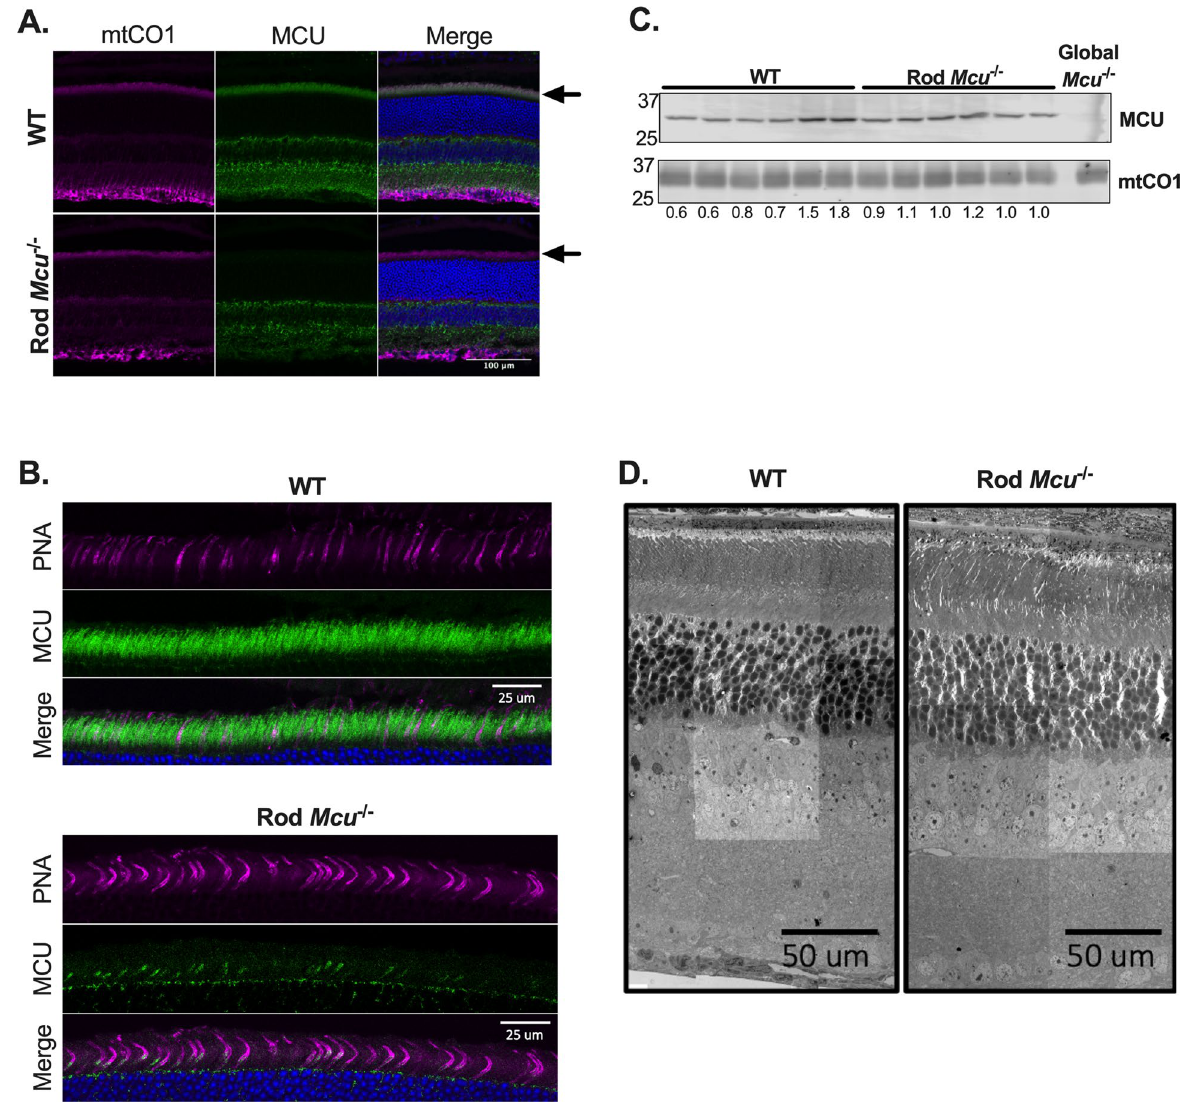
Figure 4. Rods express low levels of MCU. ( A ) Immunohistochemistry showing MCU expression in WT and Rod Mcu -/- retinas. mtCO1 (Mitochondrial Cytochrome Oxidase subunit 1) is used to label mitochondria. An arrow indicates the photoreceptor mitochondria layer. ( B ) Immunohistochemistry showing MCU expression and PNA-647 (staining cone outer segments). MCU is still expressed in cones from Rod Mcu -/- retinas. ( C ) Western blot showing MCU expression in whole retinas from Rod Mcu -/- mouse. 15 µg of retinal protein lysate was loaded in each lane. MCU expression is not significantly altered in Rod Mcu -/- retinas (1.02 ± 0.03 fold higher in Rod Mcu -/- retinas, mean ± standard deviation is reported, ns using Welch’s t test). Retinal lysate from a global Mcu -/- mouse is used as a control to show specificity of MCU antibody (far right lane). The MCU/mtCO1 ratio for each sample relative to WT average is shown under each lane (n = 6 WT and 6 Rod Mcu -/- retinas from 3 animals each). ( D ) SEM images from 6-month old WT and Rod Mcu -/- retinas (retinas from n = 3 mice were imaged, representative images from 1 WT and 1 Rod Mcu -/- retina